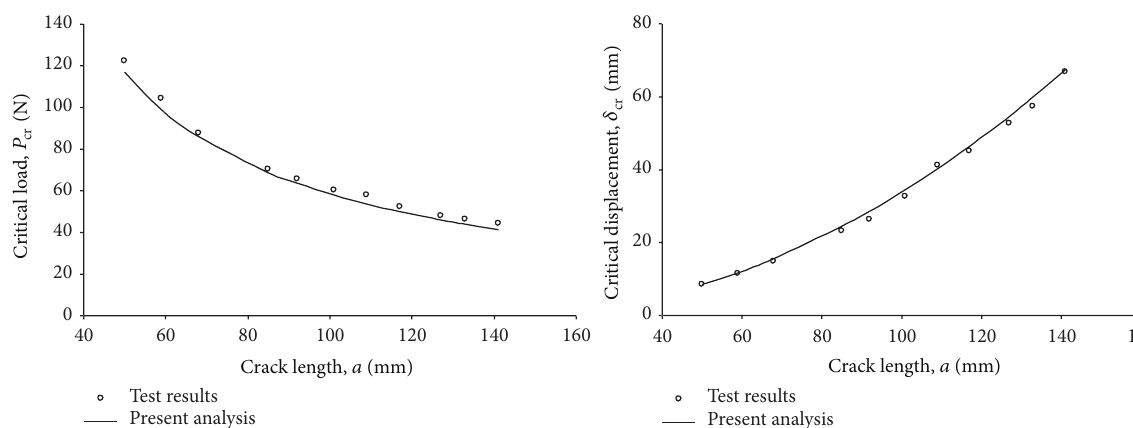
) and the corresponding displacement (𝛿 ) cr cr